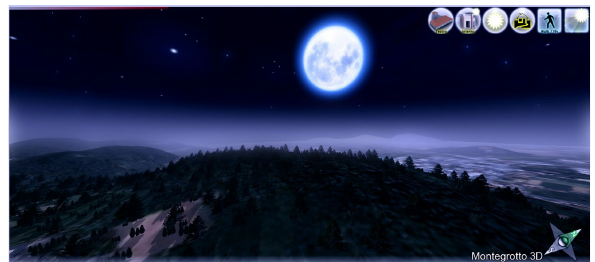
Figure 4. Multiple Sky domes and lighting conditions interactively modifiable (Montegrotto